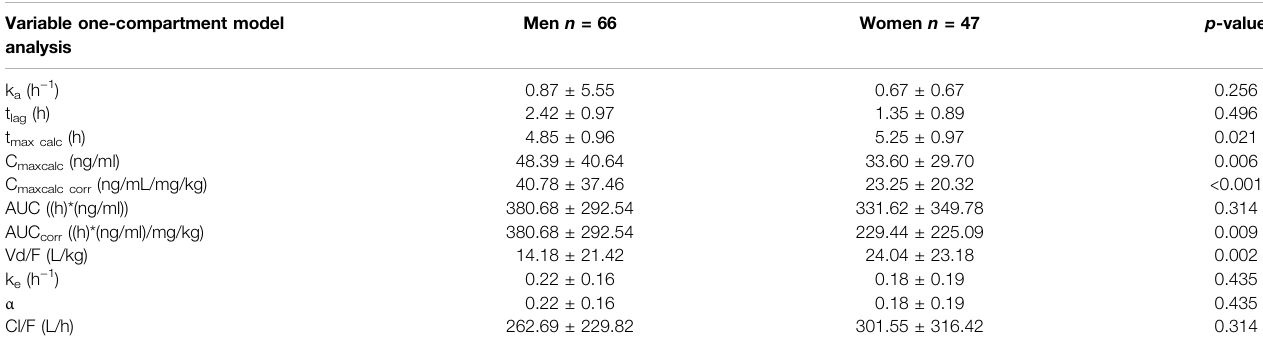
TABLE5| Pharmacokineticparametersofitraconazolecalculatedfromsetsofplasmaconcentrationsofhumansubjectsafteradministrationofasingleoraldoseof100 mg of drug obtained by one-compartment model analysis. Variable one-compartment model